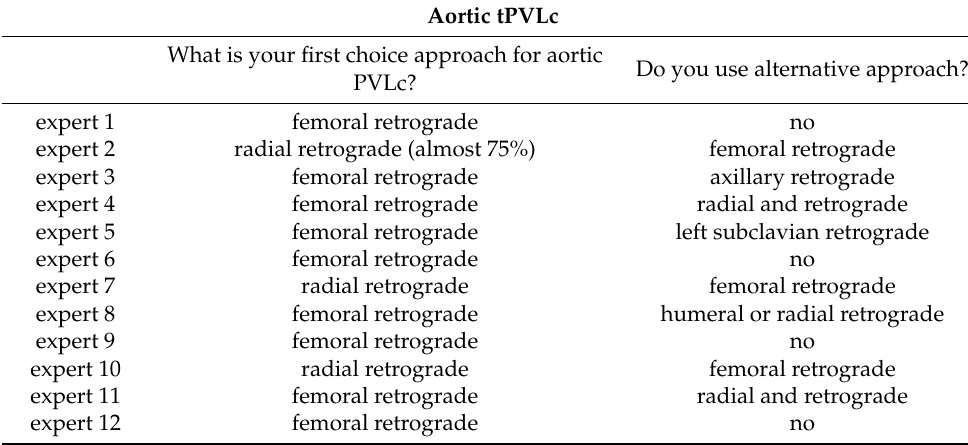
Table 4. The aortic PVL